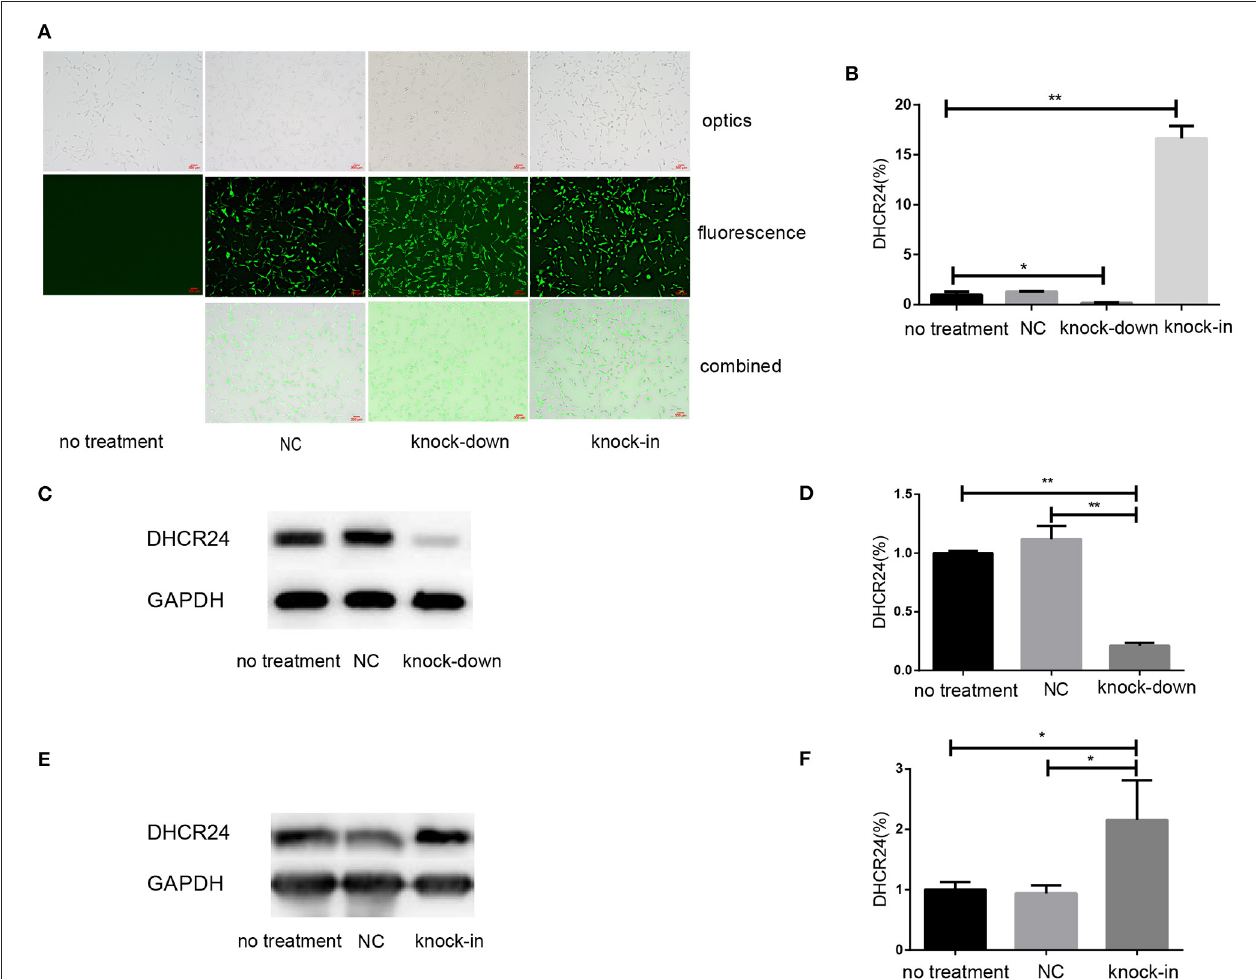
FIGURE 1 | Illustration of SH-SY5Y cells transfected with DHCR24 shRNA-lentivirus and DHCR24 cDNA-lentivirus. The SH-SY5Y cells were transfected with the lentivirus-delivered DHCR24 shRNA, DHCR24 cDNA and lentiviral vector, and used as knock-down group, knock-in group, vector control group (Negative control group, NC) respectively. The untransfected SH-SY5Y cells were used as the no treatment group. (A) DHCR24 shRNA, DHCR24 cDNA and lentiviral vector were well-expressed in the SH-SY5Y cells, as indicated by GFP (green) under fluorescence microscopy. Scale bars = 200 µ m; (B) qPCR analyses were performed and displayed a five-fold lower expression of the DHCR24 shRNA transgenes and a 15-fold higher expression of the DHCR24 cDNA transgenes. Western blot was performed to analyze the knock-down (C,D) and knock-in (E,F) of DHCR24. All the data are presented as mean ± SD of at least three individual experiments ( B–F ; n = 3). * P < 0.01, ** P < 0.001; vs. the no treatment and NC group ( C , Figure 2E , Figures 6A,Q share one loading